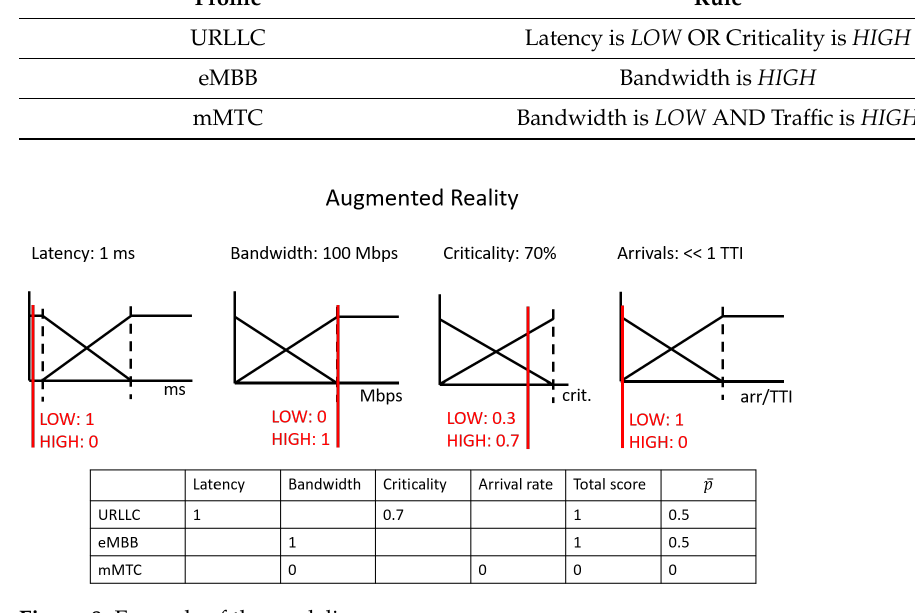
Figure 8. Example of the modeling